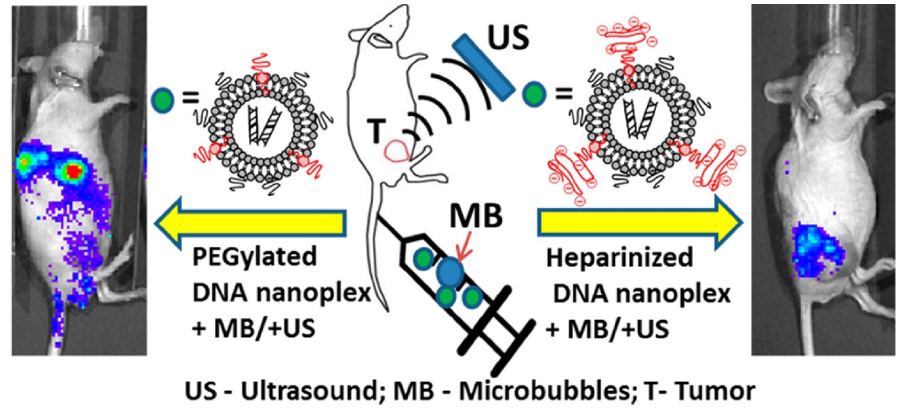
Figure 5. Intravenous administration of DNAlipHep and DNAlipPEG in tumor bearing mice with UTMD